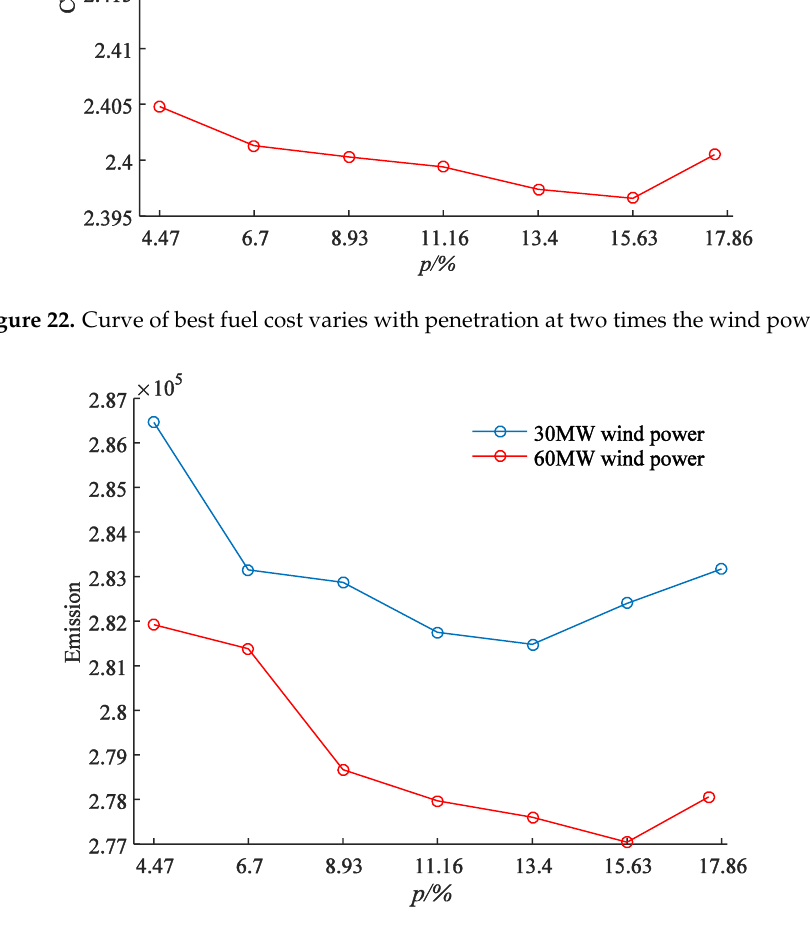
Figure 23. Curve of best pollution emission varies with penetration at two times the wind power.